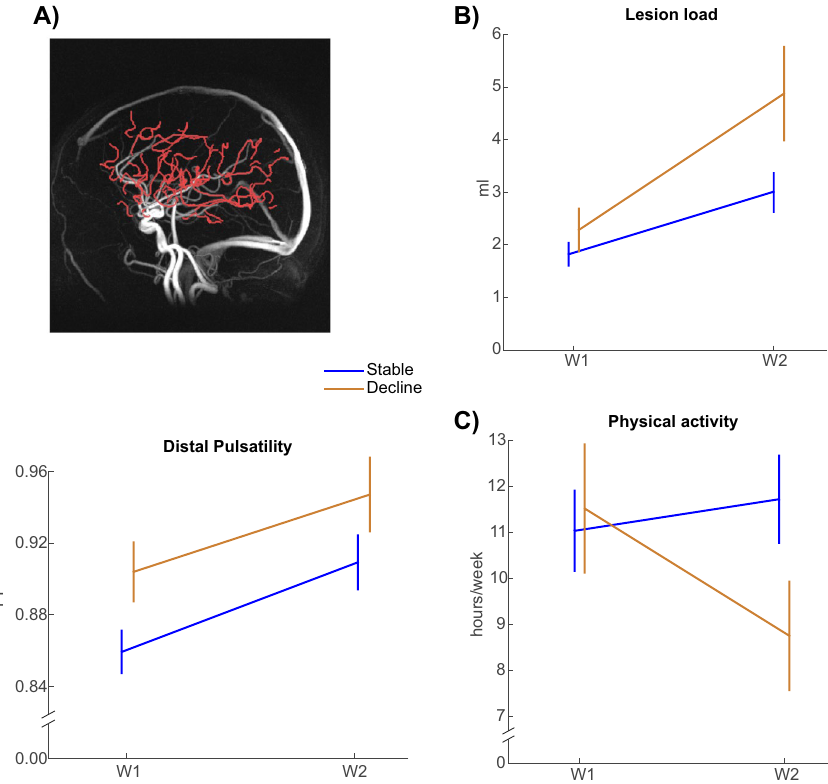
Figure 4. Comparison of Stable and Declining groups on markers of vascular health and self-reported physical activity. ( A ) Pulsatility in distal cerebral arteries. ( B ) White-matter lesions, and ( C ) Physical activity. (Mean ± 1SE). PI = Pulsatility index (unitless, see “Methods”); W =